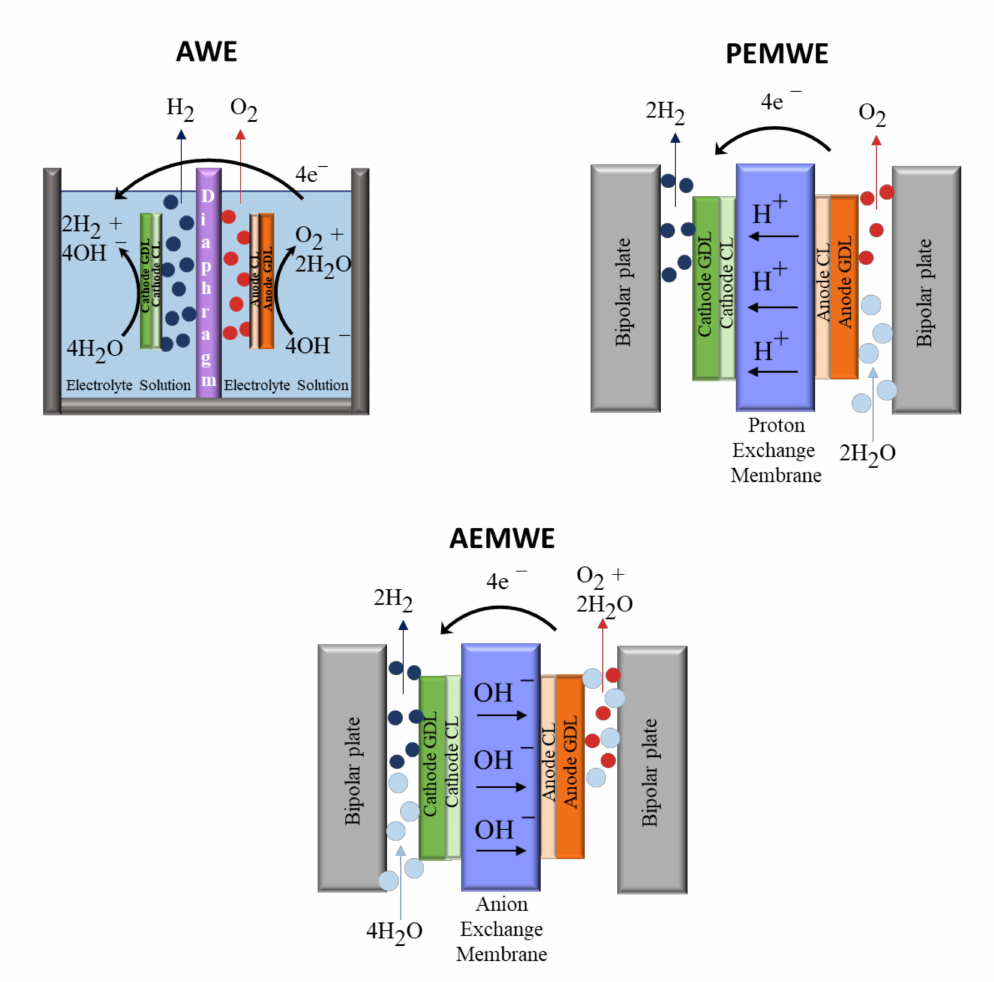
Figure 2. Schemes of typical cell configurations of low-temperature water